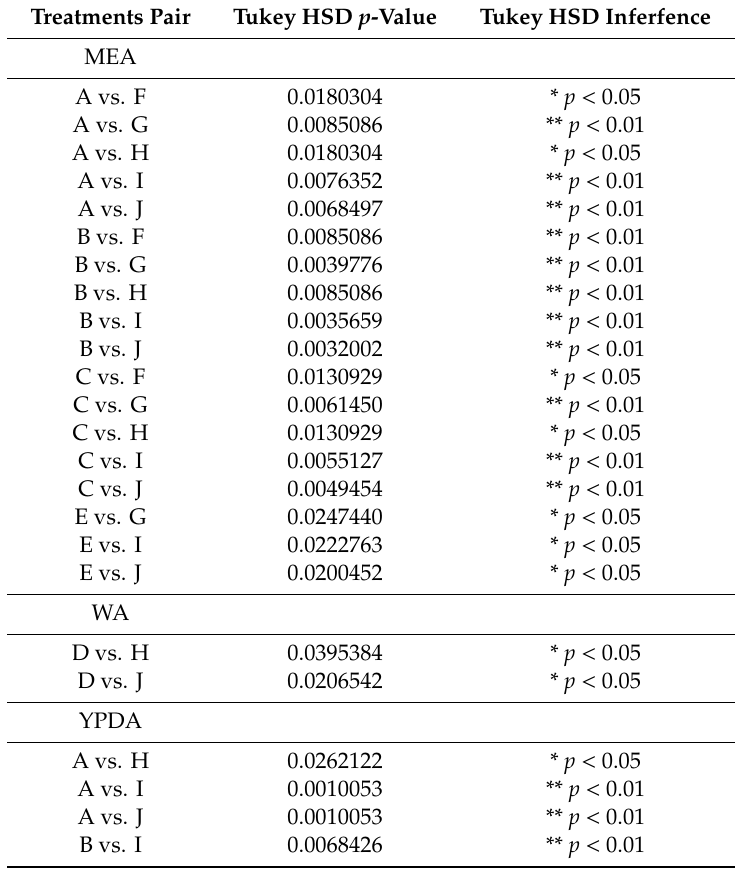
Table 3. Significant di ff erences among analyzed grape varieties for individual cultivation